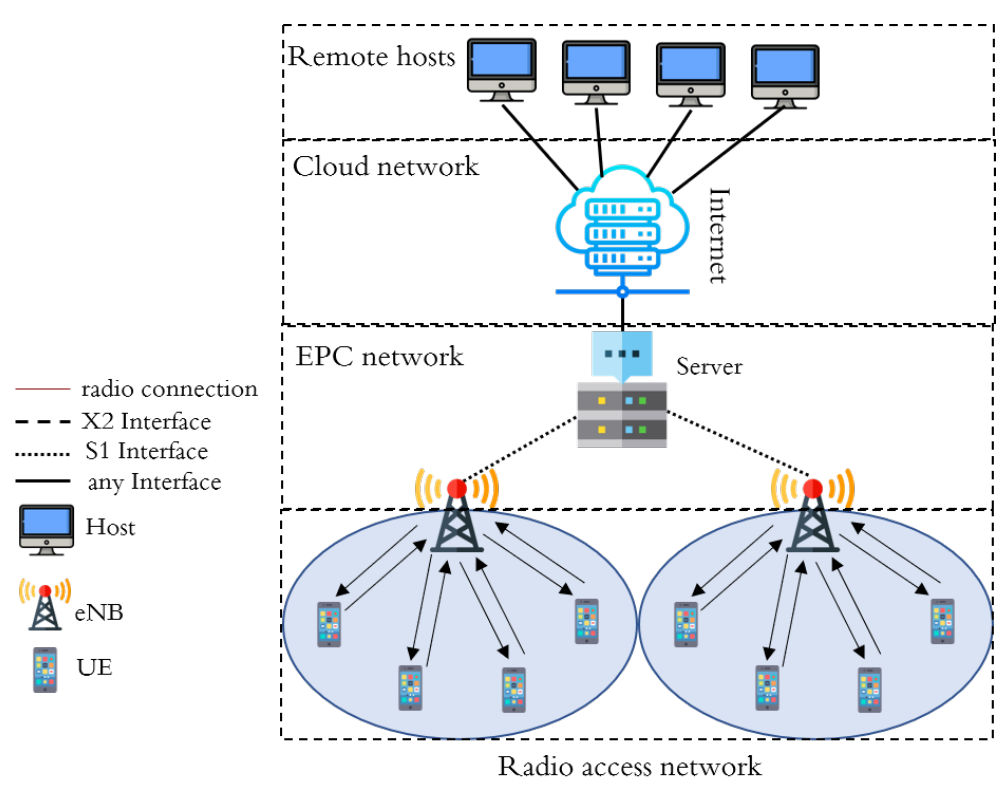
Figure 1. A typical user equipment (UE) communication in a 5th generation (5G)